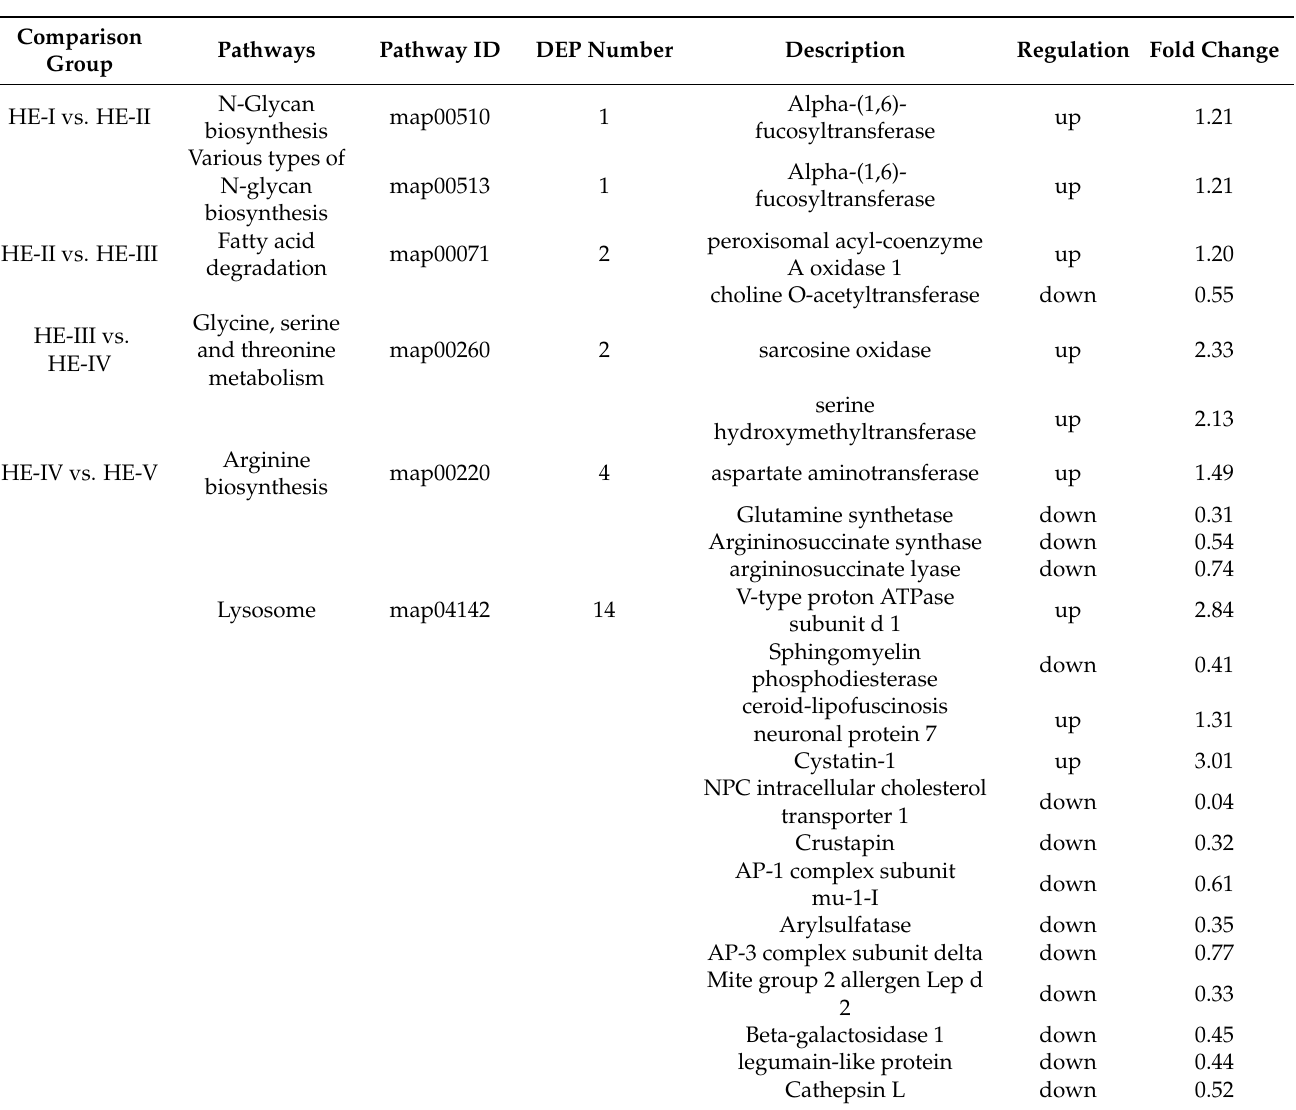
Table 3. DEPs of KEGG enrichment pathways ( p <